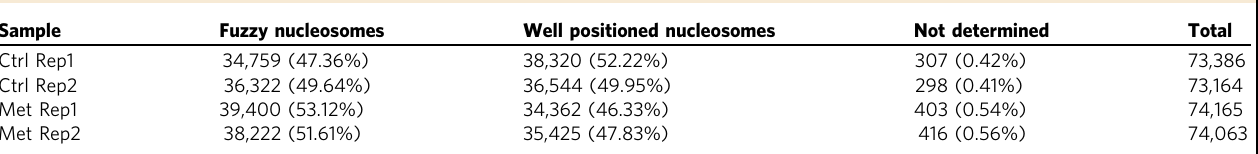
Fig. 2 Correlation between DNA methylation and nucleosome coverage genome wide. a Nucleosome positioning (in red) in a sample before (dashed lane) and after (plain lane) induction of methylation and average methylation probabilities (in blue). Plots are built around TSS and TTS (850 bp upstream and downstream from each point). Average nucleosome positioning does not change drastically upon methylation. b Percentage of CpG with methylation probability above 0.01 around well-positioned (W) nucleosomes. Nucleosome calls were considered well-positioned when nucleR peak width score and height score were higher than 0.6 and 0.4, respectively. DNA methylation is anti-correlated with nucleosome occupancy in W nucleosomes. Average methylation probability around nucleosome call center (150 bp upstream and downstream) for ( c ) Well positioned and ( d ) Fuzzy nucleosomes. e Average methylation probability per strand around nucleosome call center (75 bp upstream and downstream) of well-positioned Table 2 Distribution of the nucleosomes classi fi ed by NucleR.